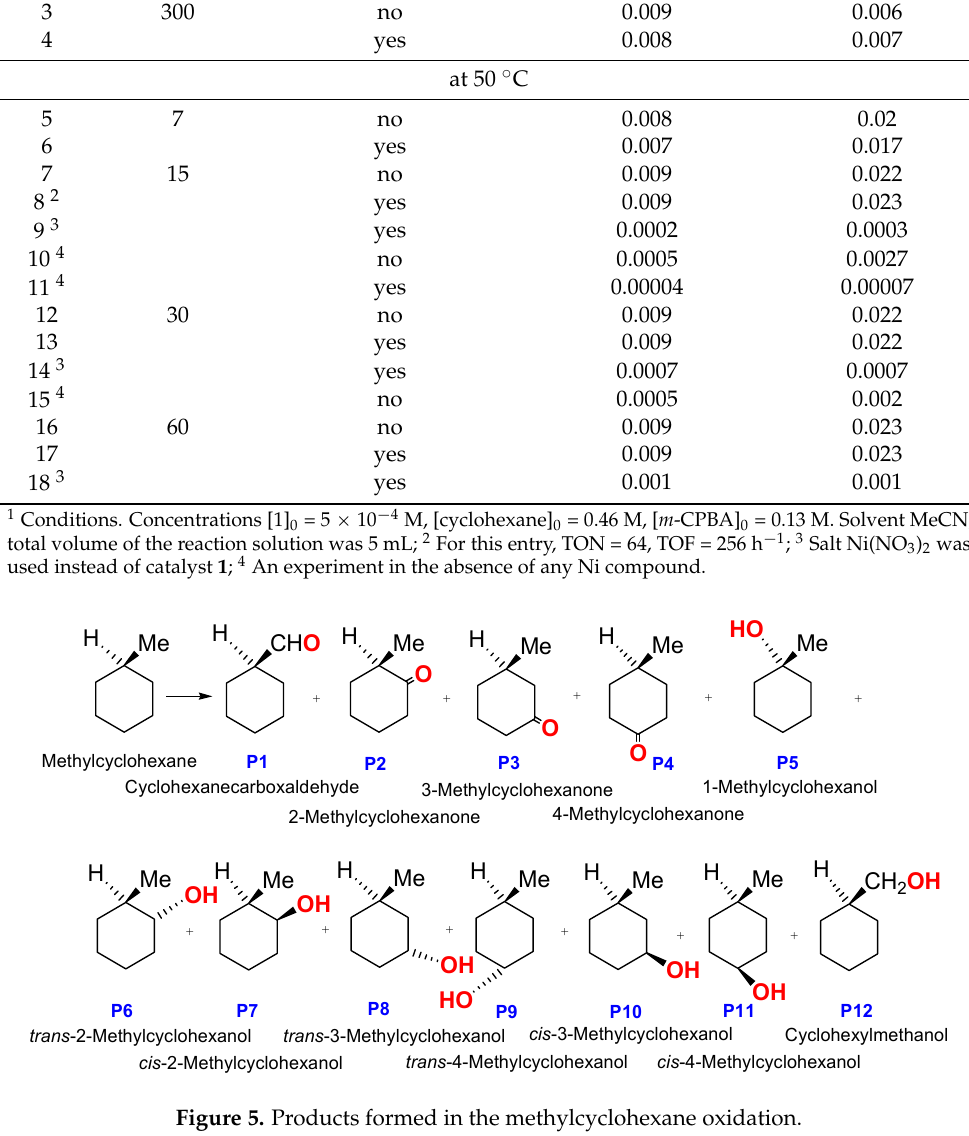
Figure 5. Products formed in the methylcyclohexane oxidation.